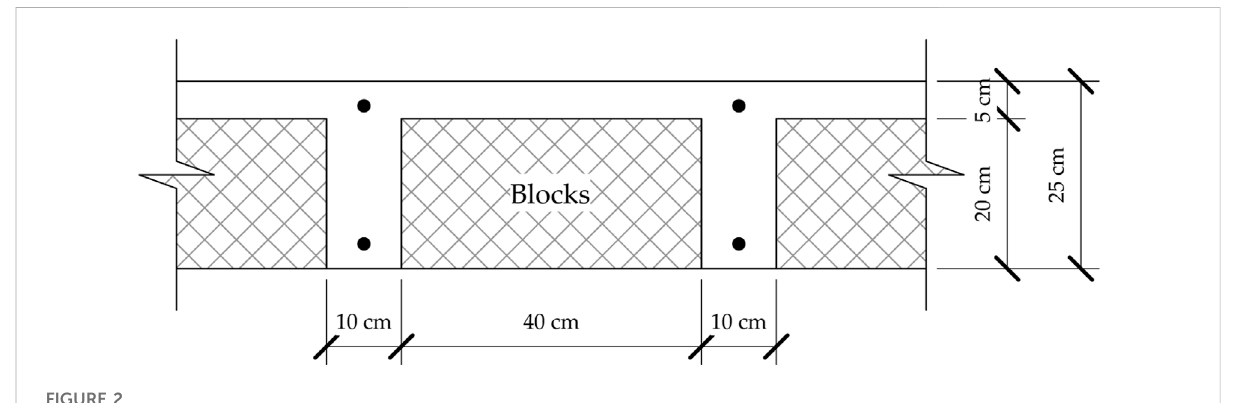
FIGURE 2 Two-way ribbed slab cross-section.